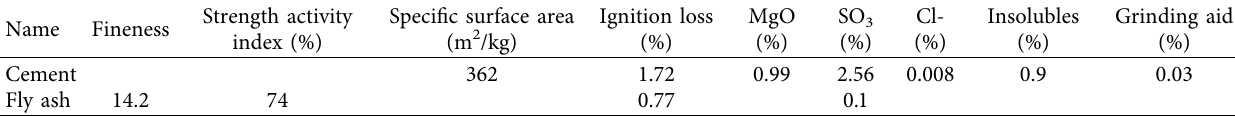
Table 1: Physical properties and chemical composition of cement and fly ash.